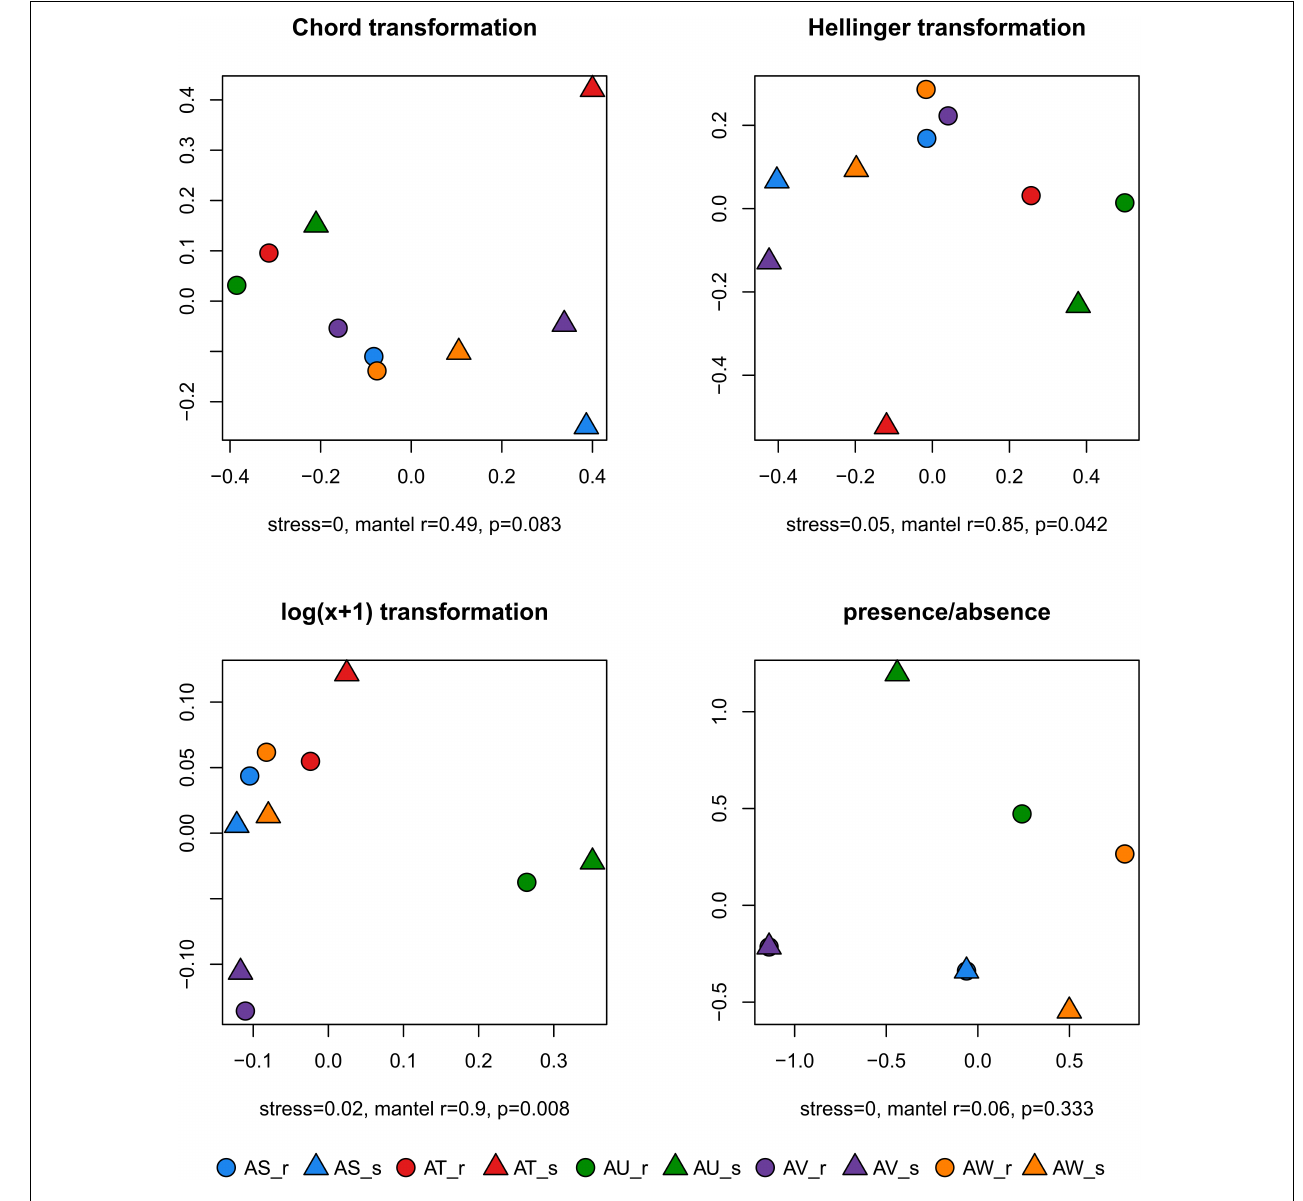
FIGURE 3 | nMDS plots depicting reads per sample (‘_r’) and morphological species (‘_s’) for the four different data transformation. Again, presences/absence and log(x + 1) transformed data are most congruent comparing specimen and species abundances/presence.